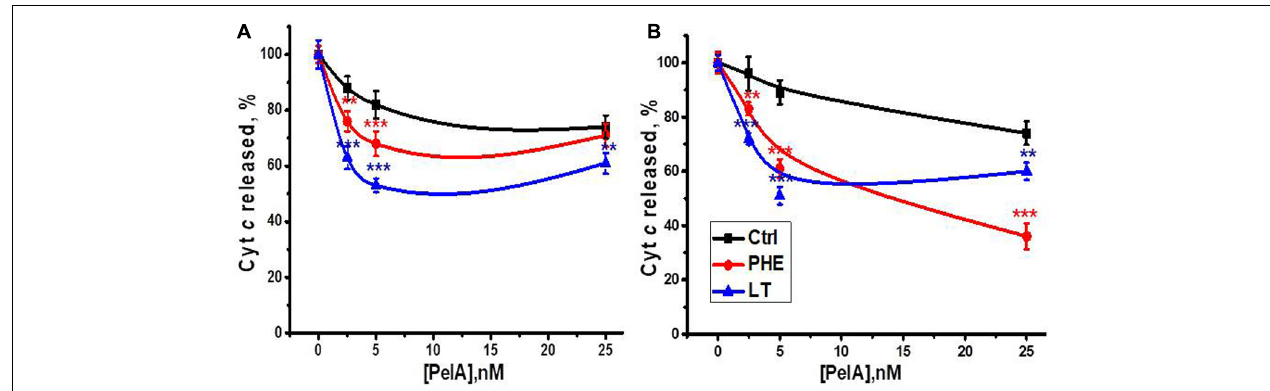
FIGURE 6 | The effect of α -conotoxin PeIA on Ca 2 + (0.9 µ M)-stimulated (A) or H 2 O 2 (0.5 mM)-stimulated (B) cyt c release from mitochondria of non-operated (Ctrl), hepatectomized (PHE) or laparotomized (LT) rats 6 h after surgery. Each point corresponds to mean ± SE; n = 3; ∗∗ p < 0.005; ∗∗∗ p < 0.0005 compared to corresponding PeIA concentration for non-operated rats mitochondria.